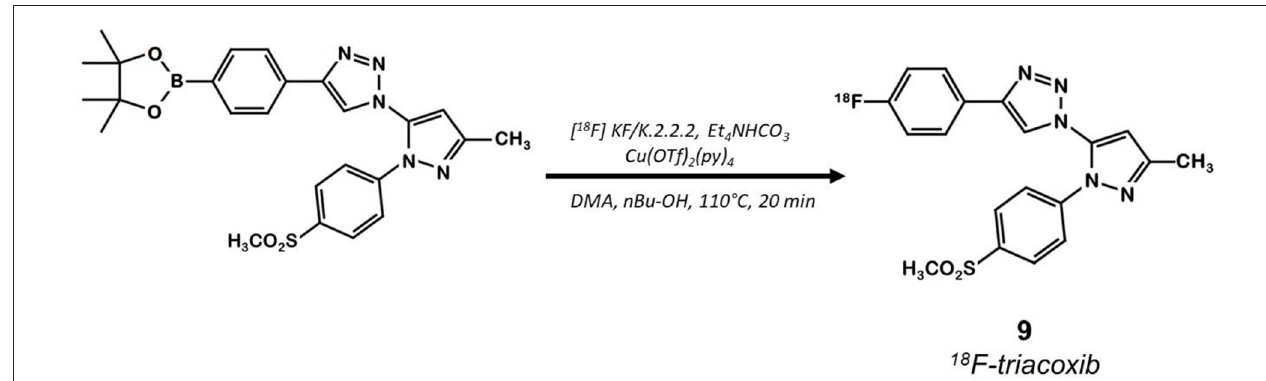
FIGURE 5 | Radiosynthesis of 18 F-6-8 probes.